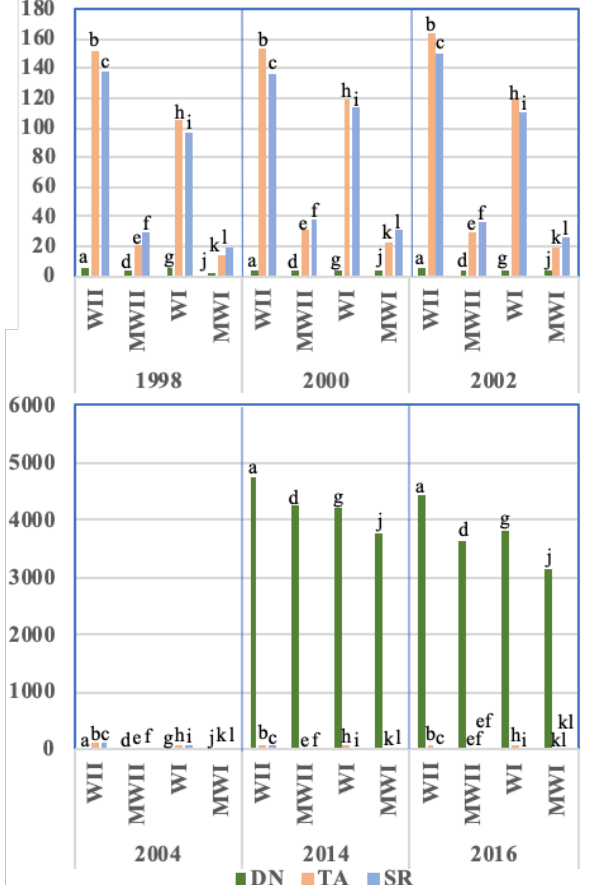
Figure 6. Average values of the Water Impoundment Index (WII), Modified Water Impoundment Index (MWII), Water Index (WI), and Modified Water Index (MWI) of shallow water for three pre-processing levels (DN, TA, SR) across six years. Letters denote significant difference (p <0.05) between pre- processing levels within a given index. Average index values for pre-processing levels were not compared across different